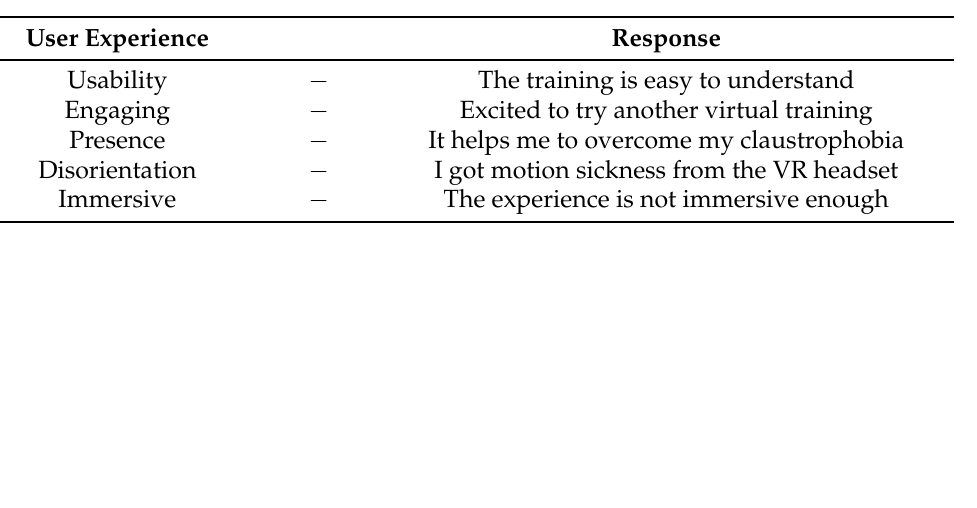
Table 1. How do you feel after experiencing the training modules using the